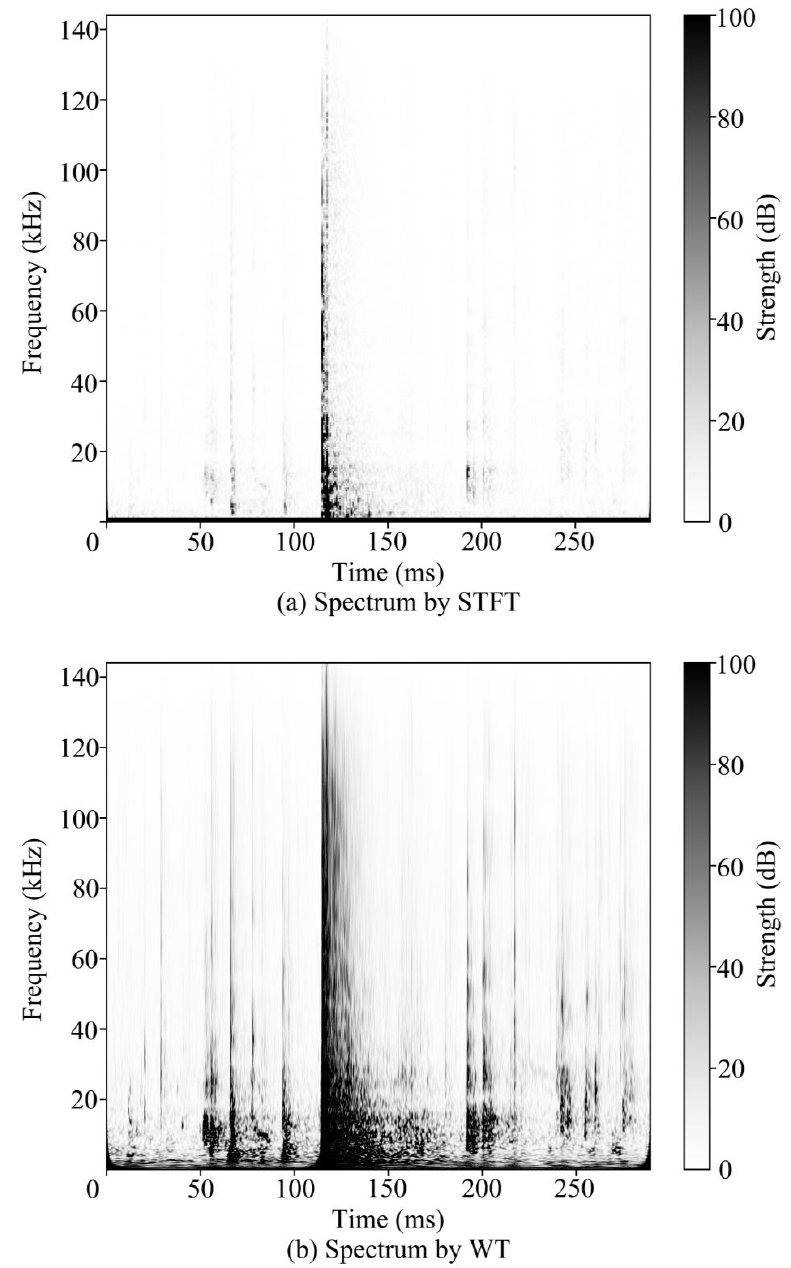
Figure 4. Time–frequency spectra provided by STFT and WT. ( a ) Spectrum calculated by STFT. ( b ) Spectrum calculated by WT. ( b ) Spectrum calculated by